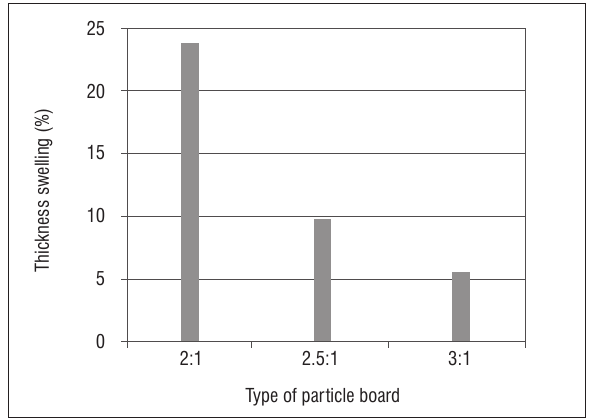
Figure 2: Thickness swelling of particle board produced using different adhesive–cassava stalk ratios (2:1, 2.5:1 and 3:1).